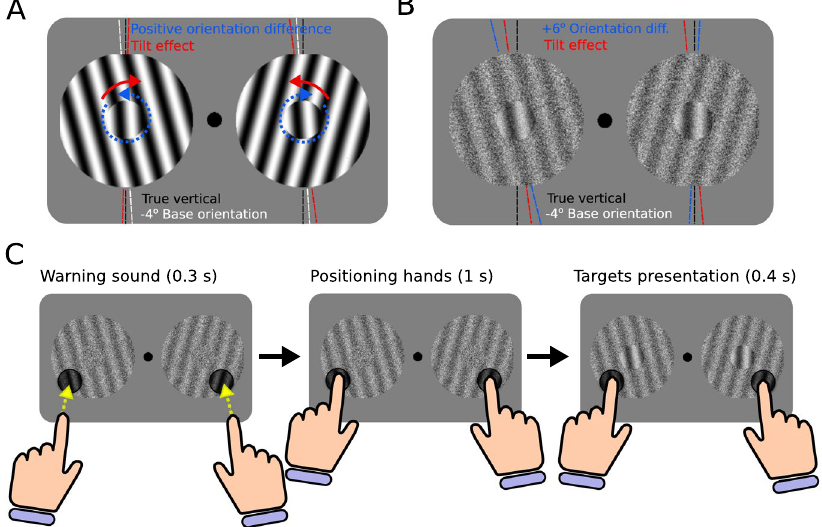
Figure 1. Experimental design ( A) For illustrative purposes, a non-noisy version of the − 4° base orientation with 0° orientation difference condition (both central gratings lean − 4° towards the left). The contextual surrounds repel both central gratings inwards (red marks), making the left central grating to look more vertical than the right one. A positive orientation difference (blue arrows) would be required to counteract the tilt illusion and make both central gratings to look equally vertical (black vertical lines). ( B ) Combining a − 4° base orientation with + 6° orientation difference condition (blue lines) makes the orientation of the right central grating appear closer to the vertical than the left central grating (black lines). This difference is predominantly indexed by the asymptotic lapse parameters ( λ in this particular example). The tilt illusion reduces the difference in verticality between both central gratings by pulling the left central grating towards the vertical and pushing the right central grating away from the vertical (red lines). ( C ) Example of a bimodal visuo-tactile (VT) trial sequence. Participants waited to hear the low-frequency tone to touch the tactile stimuli (depicted by the dark circles) overlaid on the visual surround with their index fingers. Then after 1.3 s, the two central gratings were briefly added to the presentation for 0.4 s. Finally, a high-frequency tone signaled the participants to remove their fingers from the tactile stimuli and to respond using a foot pedal which of the two central